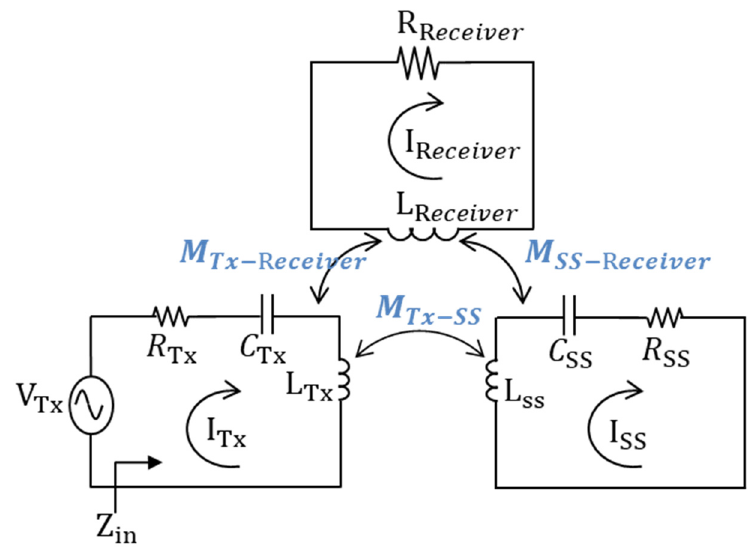
Figure 4. Equivalent circuit of the proposed WPT system with the receiver.